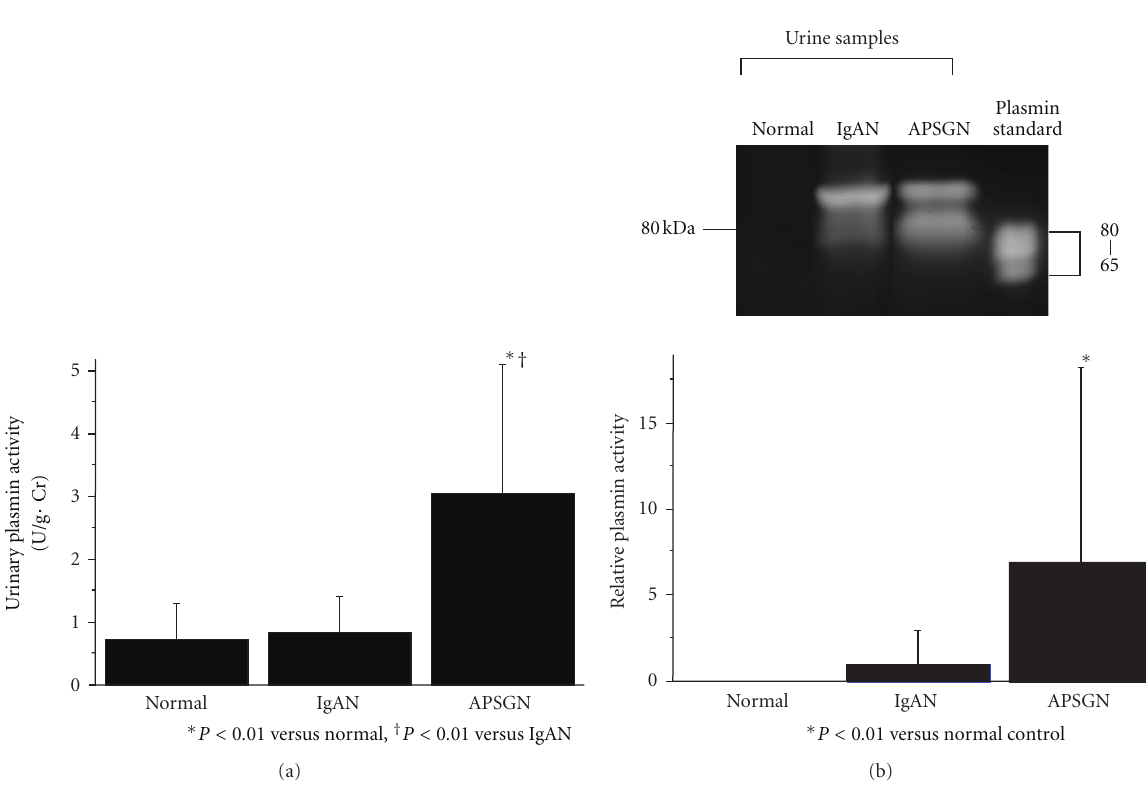
Figure 4: (a) Urinary plasmin activity assessed by chromogenic assay and corrected for urinary creatinine concentration. Results are expressed as corrected mean activity ± SE. ∗ P < 0 . 01 versus normal control; † P < 0 . 01 versus IgAN. (b) Representative casein gel zymography results for a plasmin standard and urine supernatants from normal controls, patients with IgAN, and patients with APSGN. Graph shows mean ± SE of the density of 80-kDa bands in casein gel zymography expressed in arbitrary units. ∗ P < 0 . 05 versus normal controls.